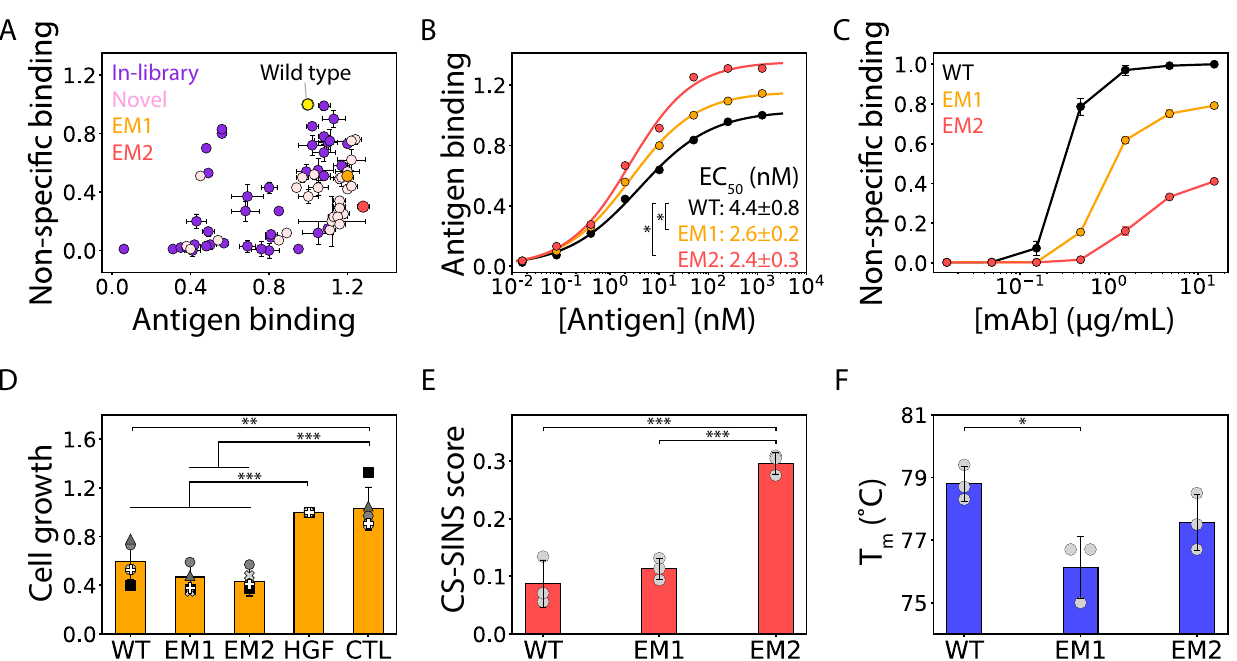
Fig. 6 Emibetuzumab mutants co-optimized for af fi nity and speci fi city also display high bioactivity and stability. A Antigen (HGFR, 1nM) and non- speci fi c (ovalbumin, 0.1mg/mL) binding measurements for soluble IgGs. B Concentration-dependent antigen binding of antibody mutants (EM1 and